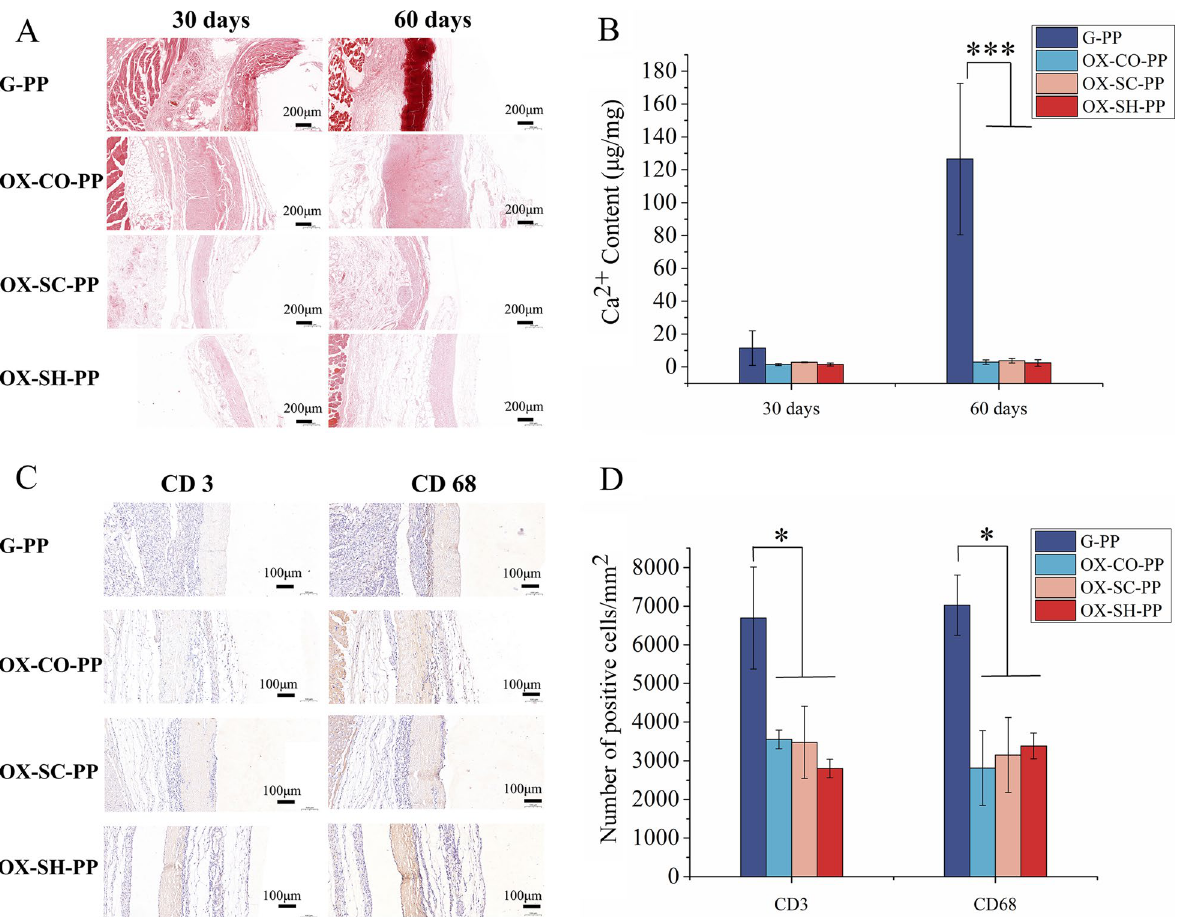
Fig. 5 A Calcium contents of G-PP, OX-CO-PP, OX-SC-PP and OX-SH-PP after subcutaneous implantation in SD rats for 30 days and 60 days. (n 6, ***p < 0.001). B Alizarin red stained sections of different cross-linked valve after implantation for 30 days and 60 days. (bar = C Immunohistochemistry with CD3 and CD 68 markers of different cross-linked valve after subcutaneous implantations in rats for 7 days. (bar 100 μm). D The numbers of CD3-positive cells and CD68-positive cells aggregated around the specimens after implantation for 7 =